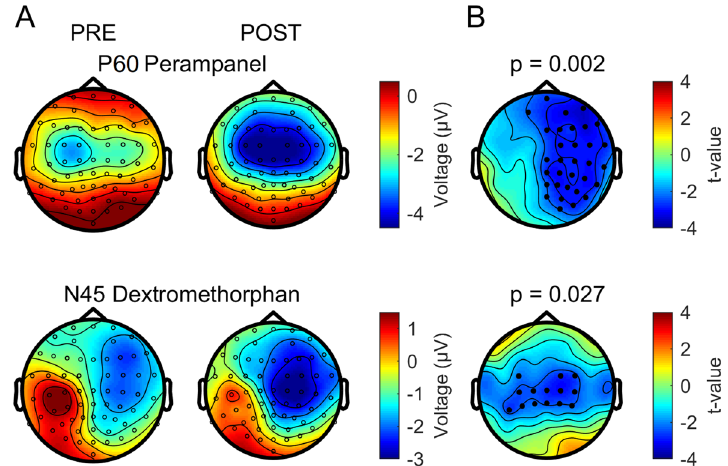
Figure 3. Topographical surface voltage maps for significantly different TMS-evoked EEG potential (TEP) components. ( A ) Topography of the P60 TEP before (left) and after (right) intake of perampanel (top row) and topography of the N45 TEP before (left) and after (right) intake of dextromethorphan (bottom row). ( B ) T -value statistical maps with channels belonging to significant electrode clusters (respective p-values are reported above the cluster topoplots) highlighted as black dots. Figure generated with MATLAB R2016a (https:// www. mathw orks. com) and the Fieldtrip Matlab toolbox (http:// www. field tript oolbox. org).